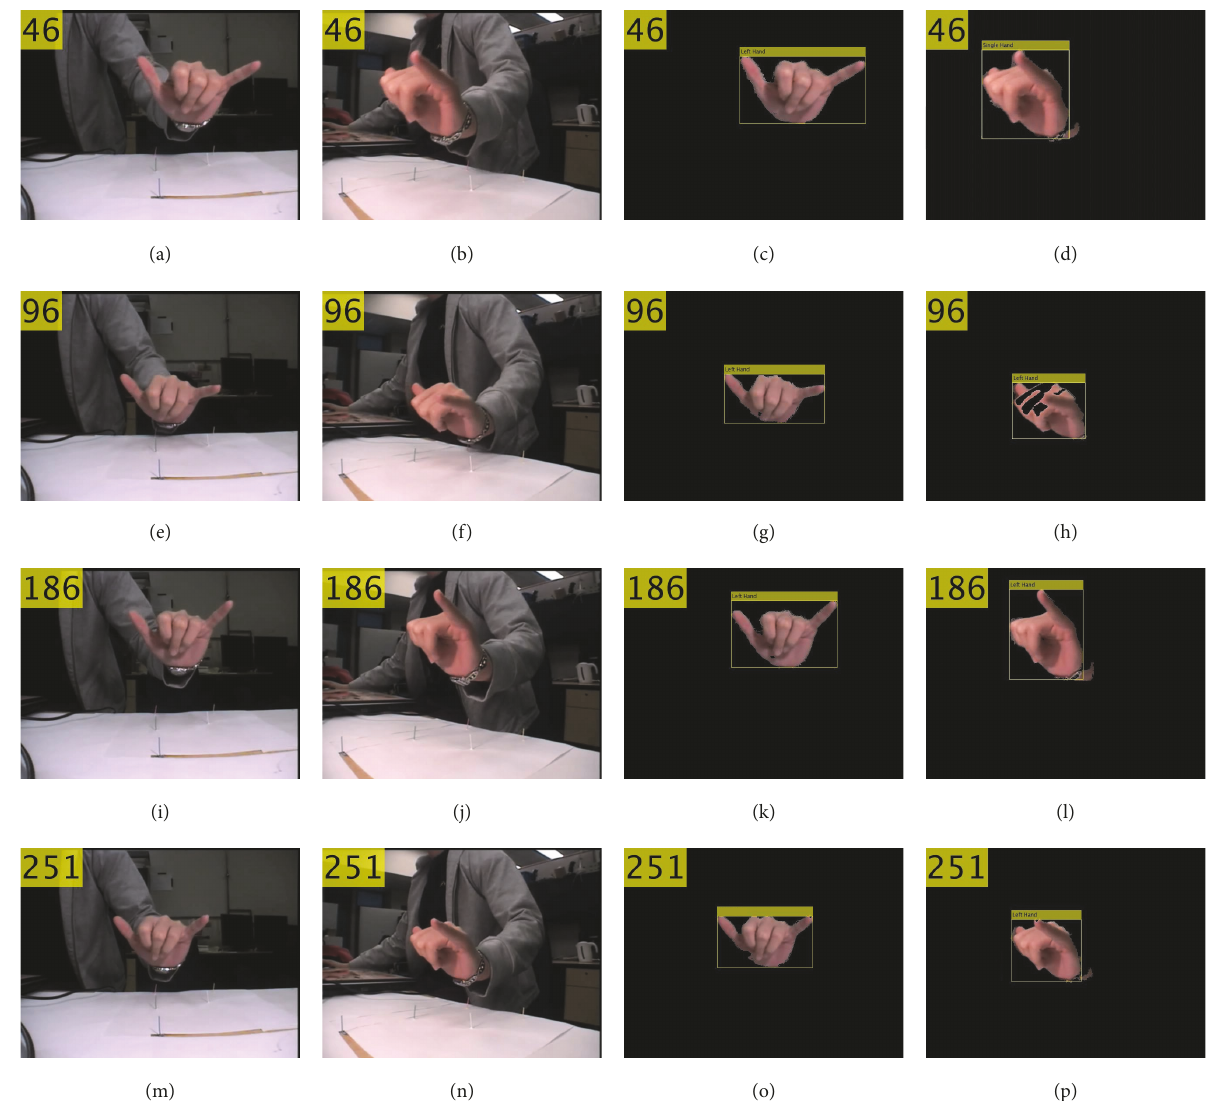
Figure 9: Sample frames from gesture video with a hand moving and the KF tracking result. The fist column ((a), (e), (i), and (m)) and the second column ((b), (f), (j), and (n)) display the original frame clipped from camera 𝐶 1 and camera 𝐶 2 , respectively. The tracking result for both cameras views are showed in the third column ((c), (g), (k), and (o)) and fourth column ((d), (h), (l), and